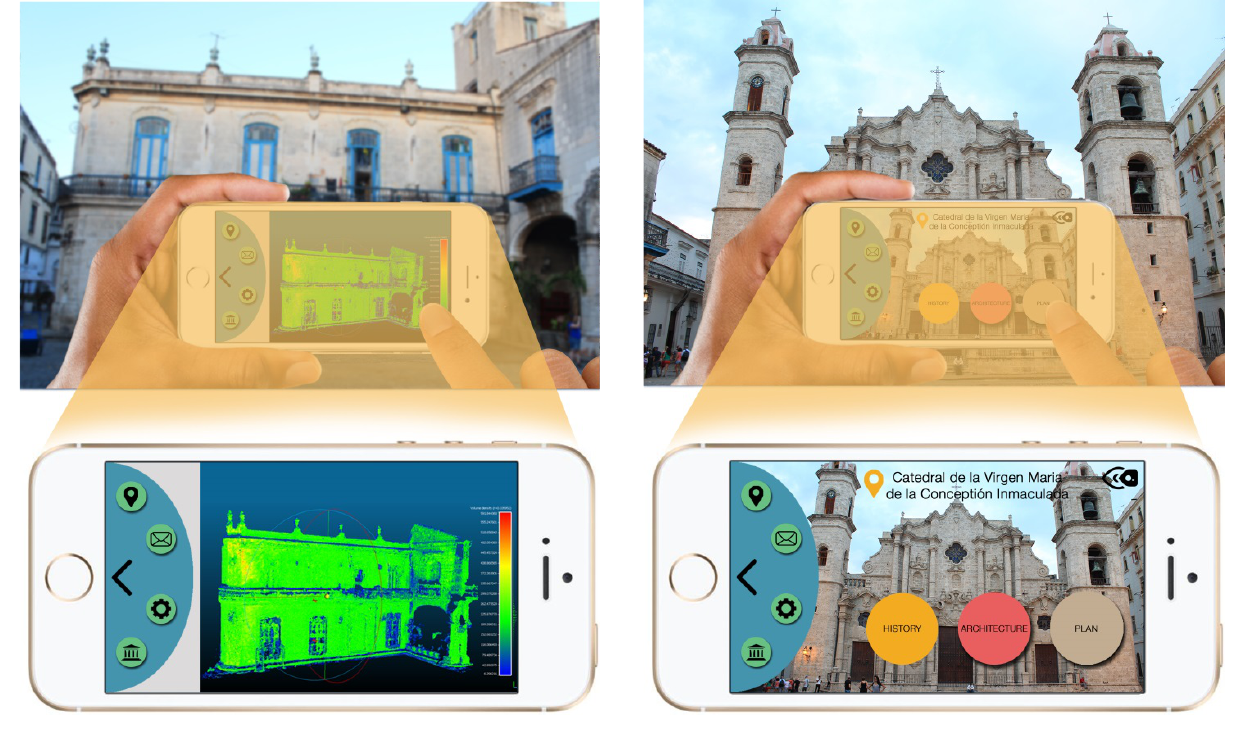
Figure 10. Example of an application of aumented reality (Casa de Baños - Plaza de la Catedral)